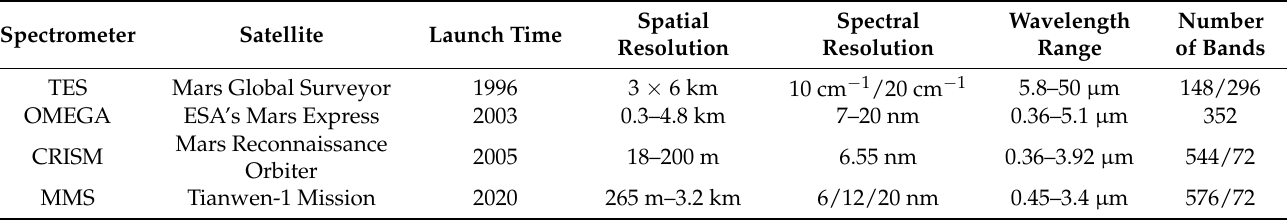
Table 1. Some of the Mars hyper-spectrometer and their